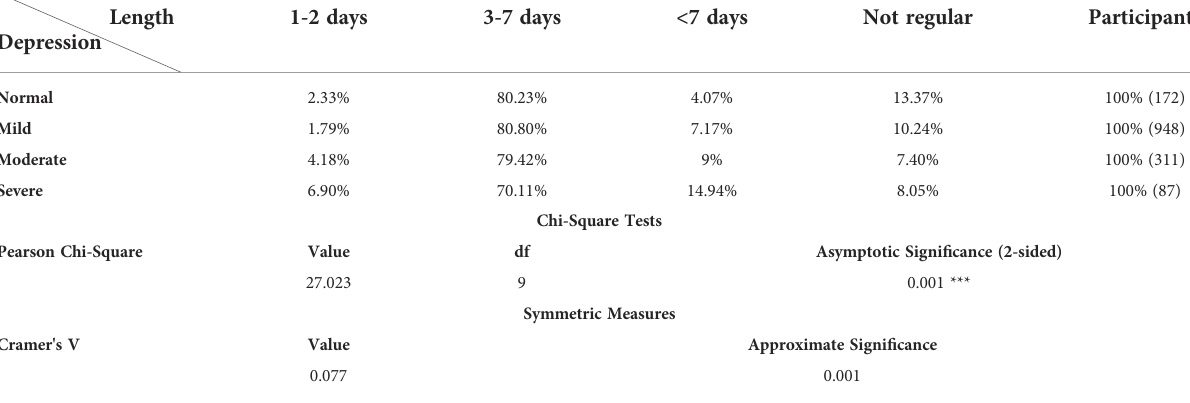
TABLE 2A Cross-tabulation analysis between the menses length and BDI.